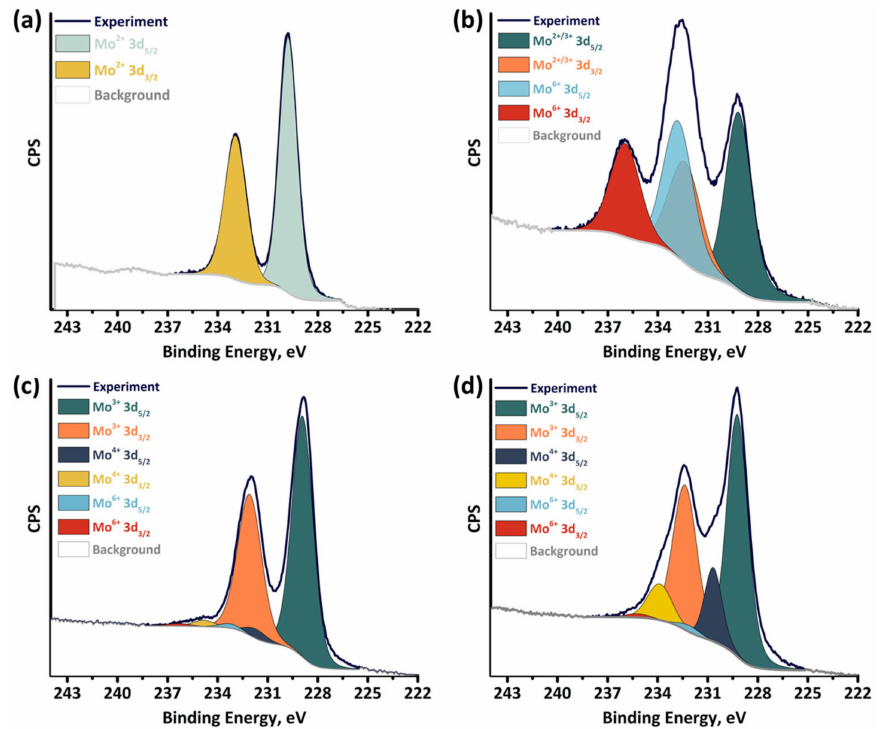
Figure 5. XPS spectra showing the Mo3d core levels in the Mo 6 Br 12 ( a ), Mo 6 ( b ), Mo 5 red ( c ), and Mo 5 ox ( d